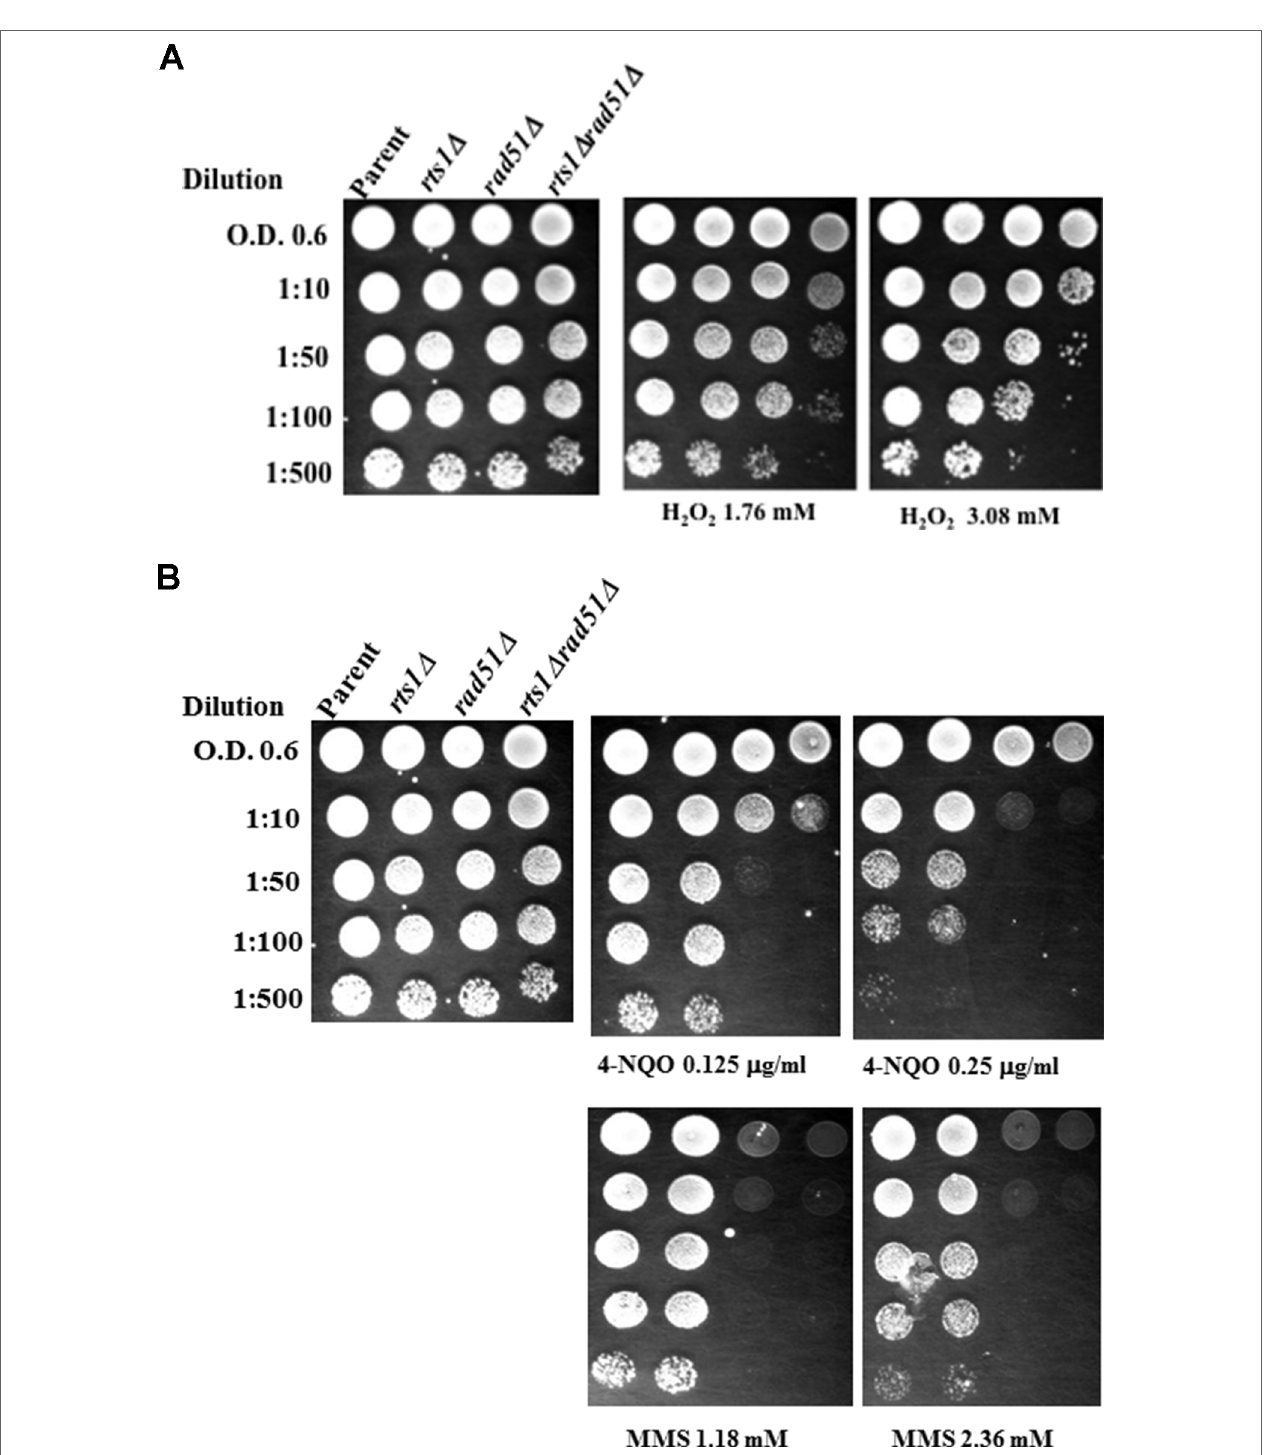
fIGURe 2 | Deletion of the RTS1 gene sensitizes the rad51Δ mutant to H 2 O 2 , but not to 4-nitroquinoline-1-oxide or methyl methanesulfonate. (A , B) Spot test analyses were performed as in figure 1 . 4-Nitroquinoline-1-oxide (4-NQO), methyl methanesulfonate (MMS). The results are representative of three independent experiments.